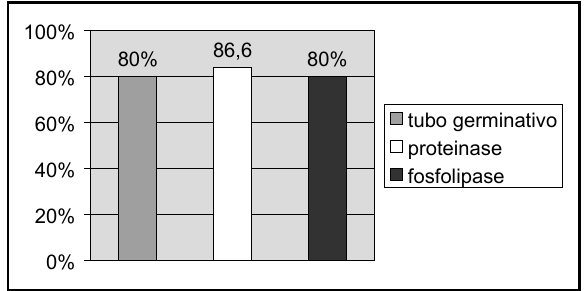
Figura 2 – Fatores de virulência em Candida spp. isoladas de pacientes diabéticos do Ambulatório de Endocrinologia do